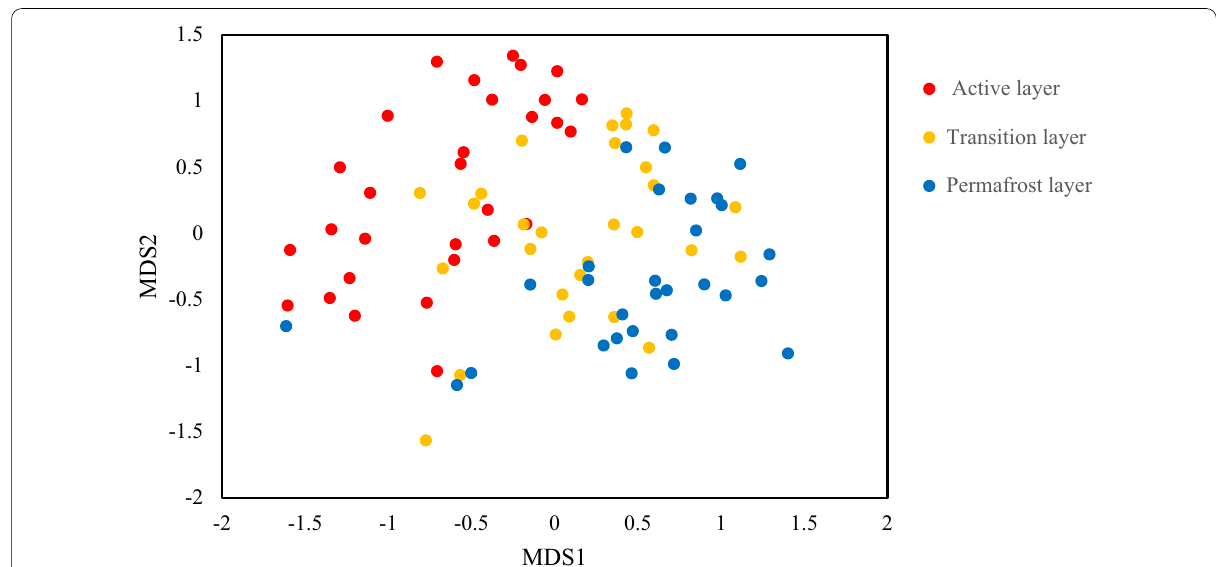
Fig. 5 Nonmetric multidimensional scaling (NMDS) analysis (Stress dissimilarities among bacterial communities from the three soil layers: active (red), transition (yellow), and permafrost